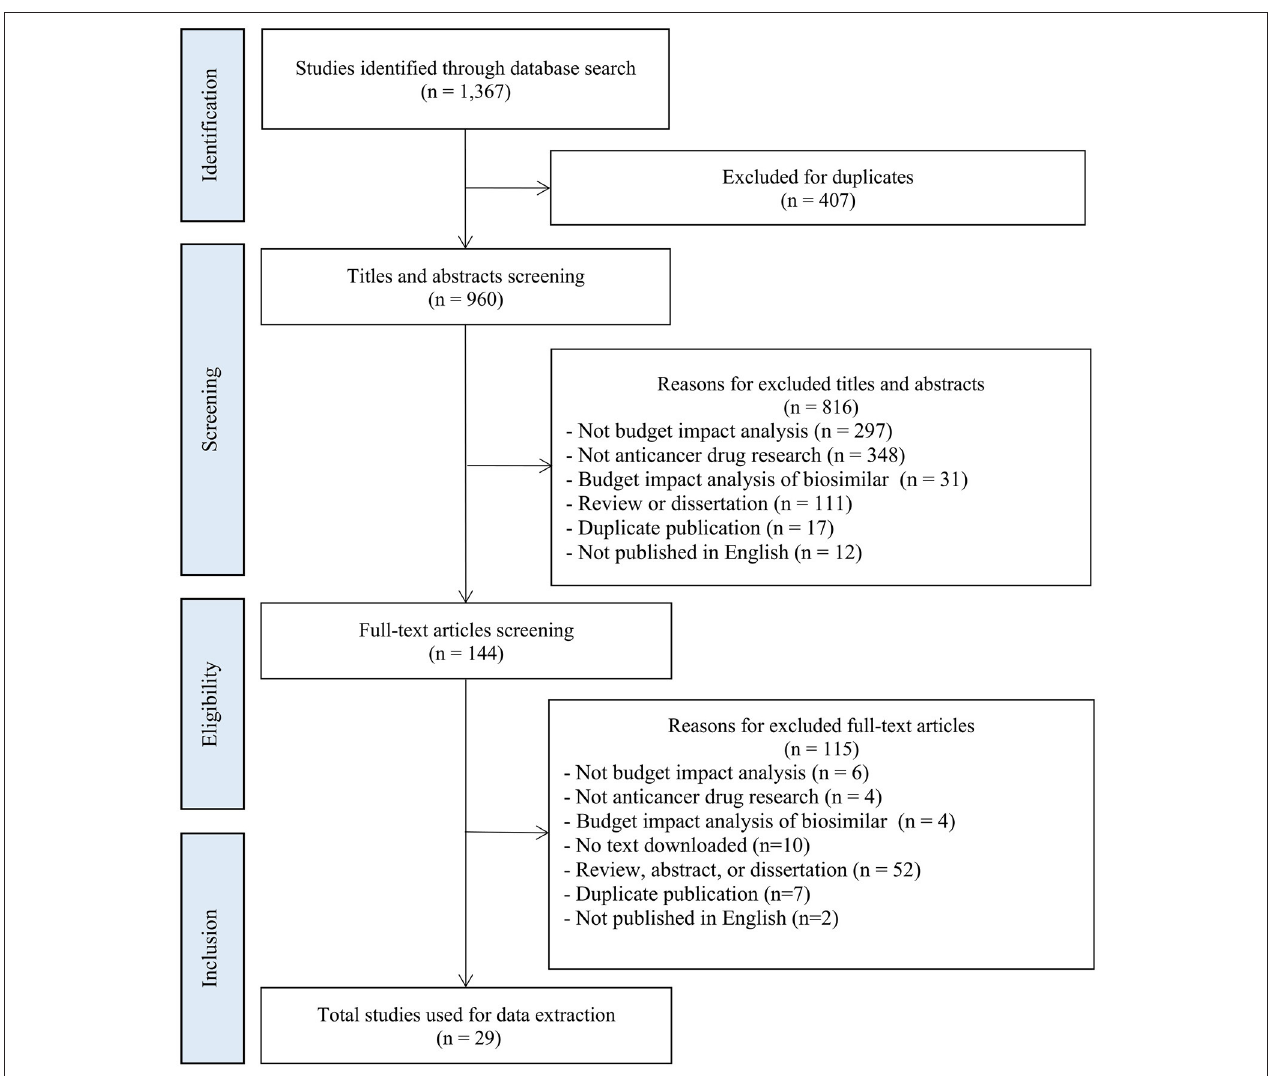
FIGURE 2 | Flow diagram of literature search and study